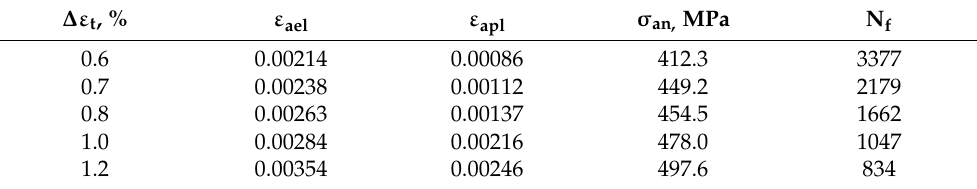
Table 3. Mechanical characteristics of HR6W alloy determined in low-cycle fatigue tests at 650 °C. ∆ ε t , %